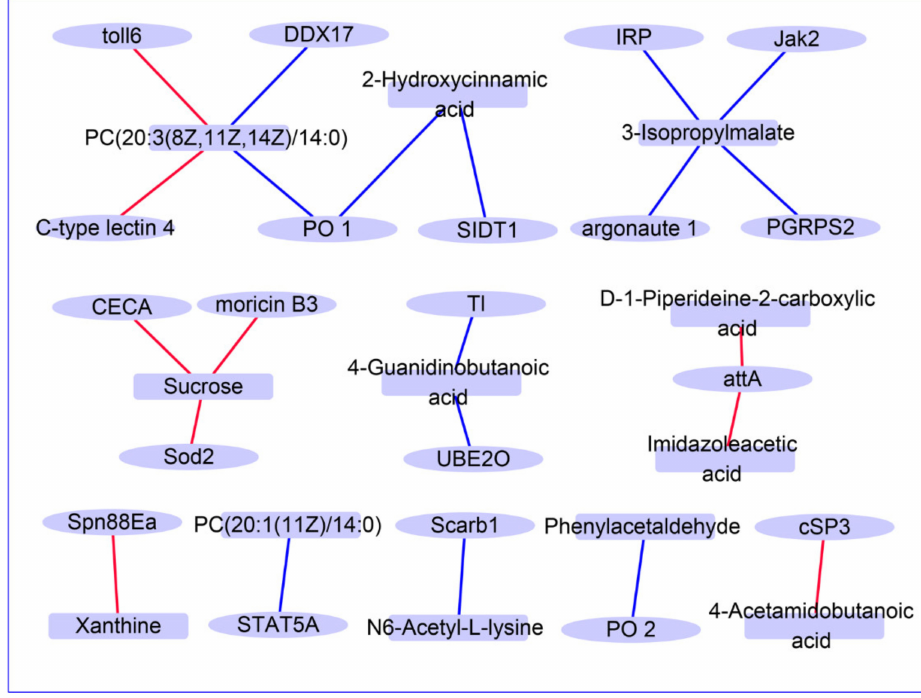
Figure 8. The network diagram of immune-related DE metabolite-DEG pairs. The ovals represent the differentially expressed (DE) metabolites, and the boxes represent the differentially expressed genes (DEGs). The red line connects the positive correlation pair, and the blue line connects the negatively correlated DE metabolite-DEG pairs.